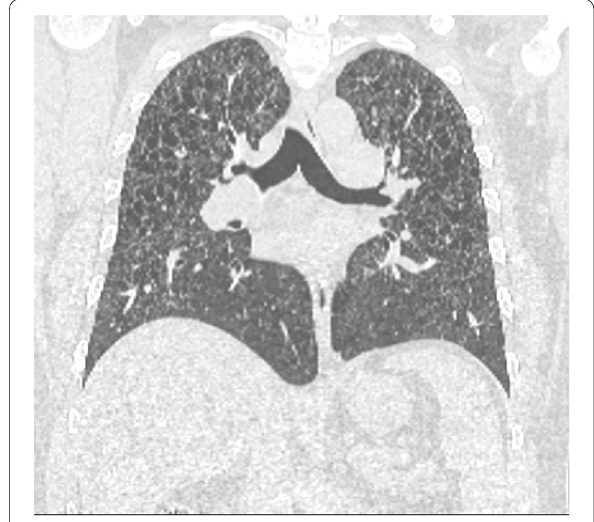
Fig. 4 HRCT of the chest, coronal reconstruction image, demonstrating apicobasal gradient in distribution of cysts with predominant involvement of upper lobes and sparing of lung